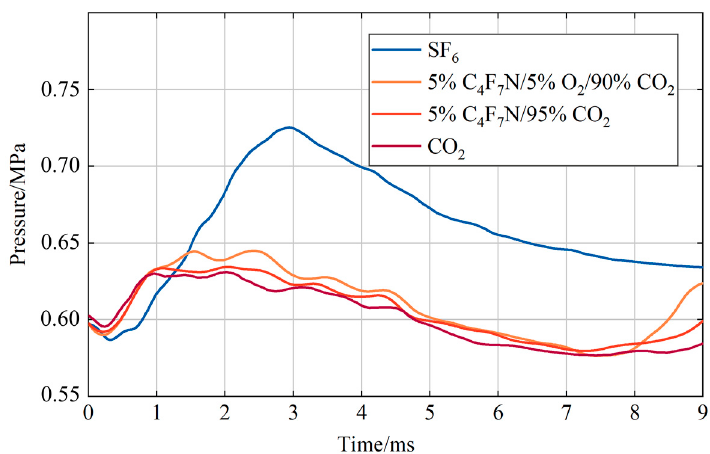
Figure 4. Pressure in the expansion chamber.